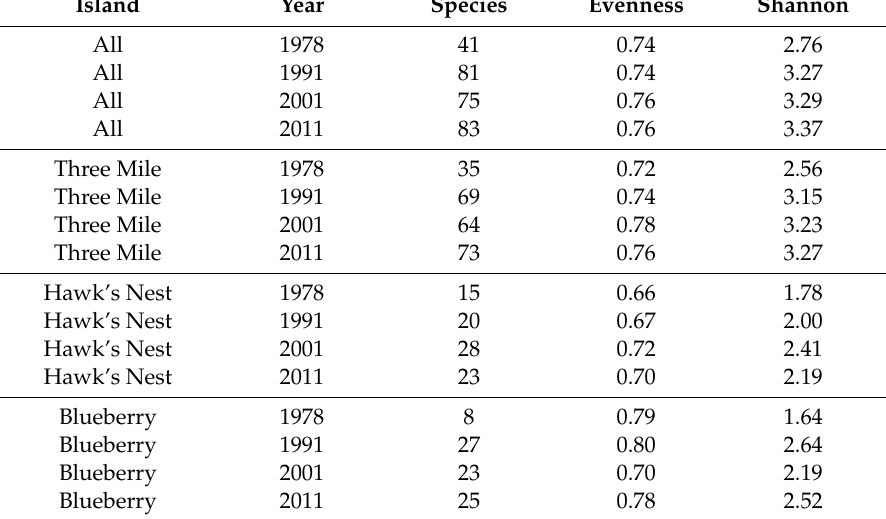
Table 3. Understory data compilation including species richness (Species), species evenness, and Shannon’s Diversity Index (Shannon). Data were compiled for all plots found on all islands, TMI, HNI, and BI respectively. Shannon’s Diversity Index was calculated using the EstimateS software